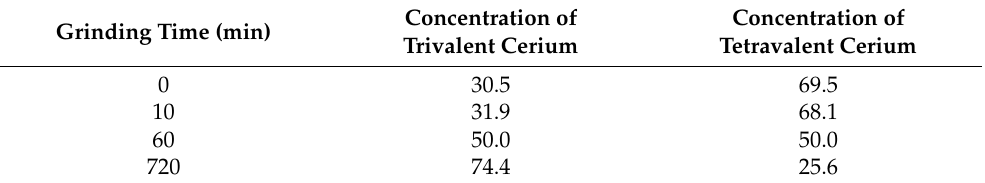
Table 4. Concentration of tri- and tetravalent cerium samples without and with grinding, based on the X-ray absorption near-edge structure analysis in cerium K-edge (%) [14]. Concentration of Concentration of Grinding Time (min) Trivalent Cerium Tetravalent Cerium 0 30.5